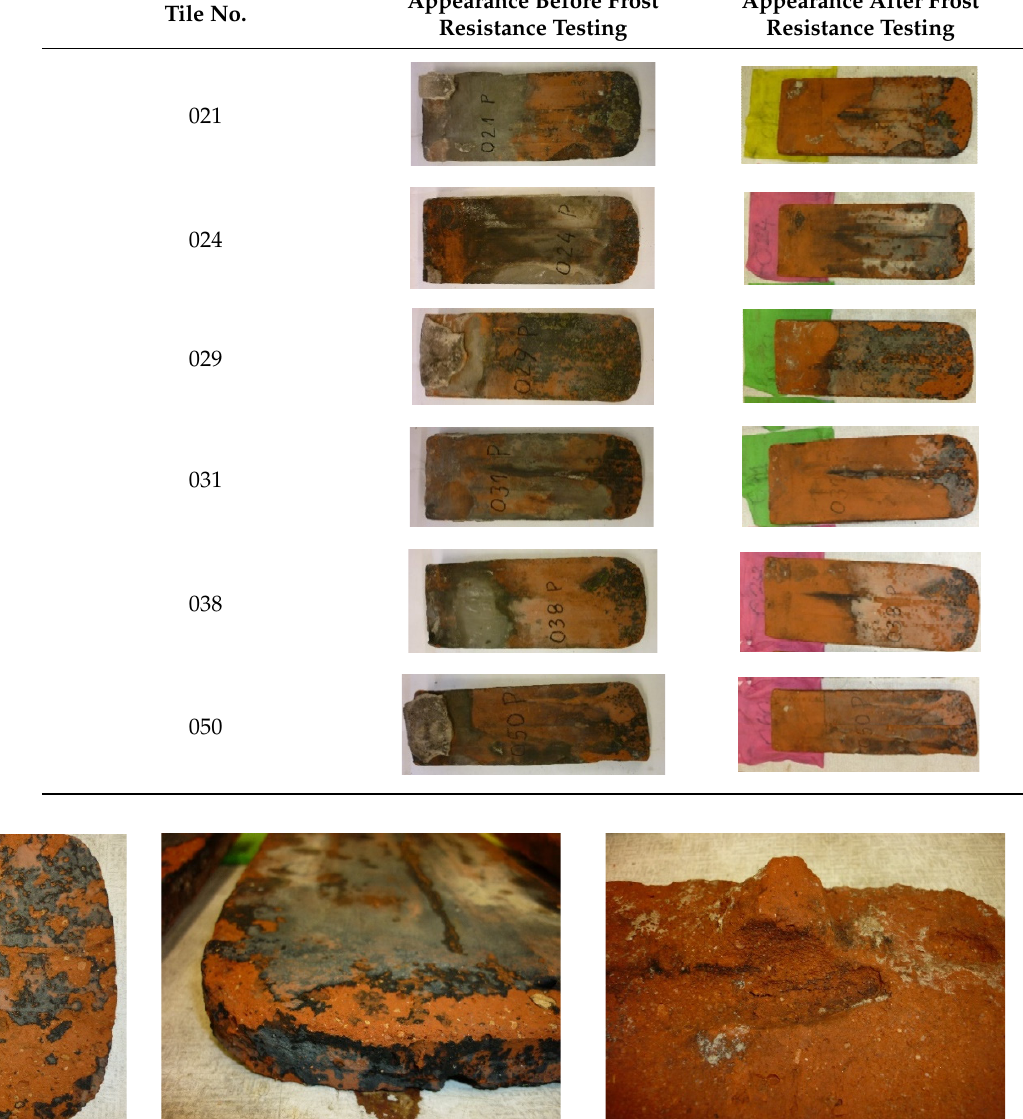
Figure 7. Roof tiles in a climate chamber. Table 1. Comparison of the visual condition of the selected tiles before and after the frost resistance test. Tile No.